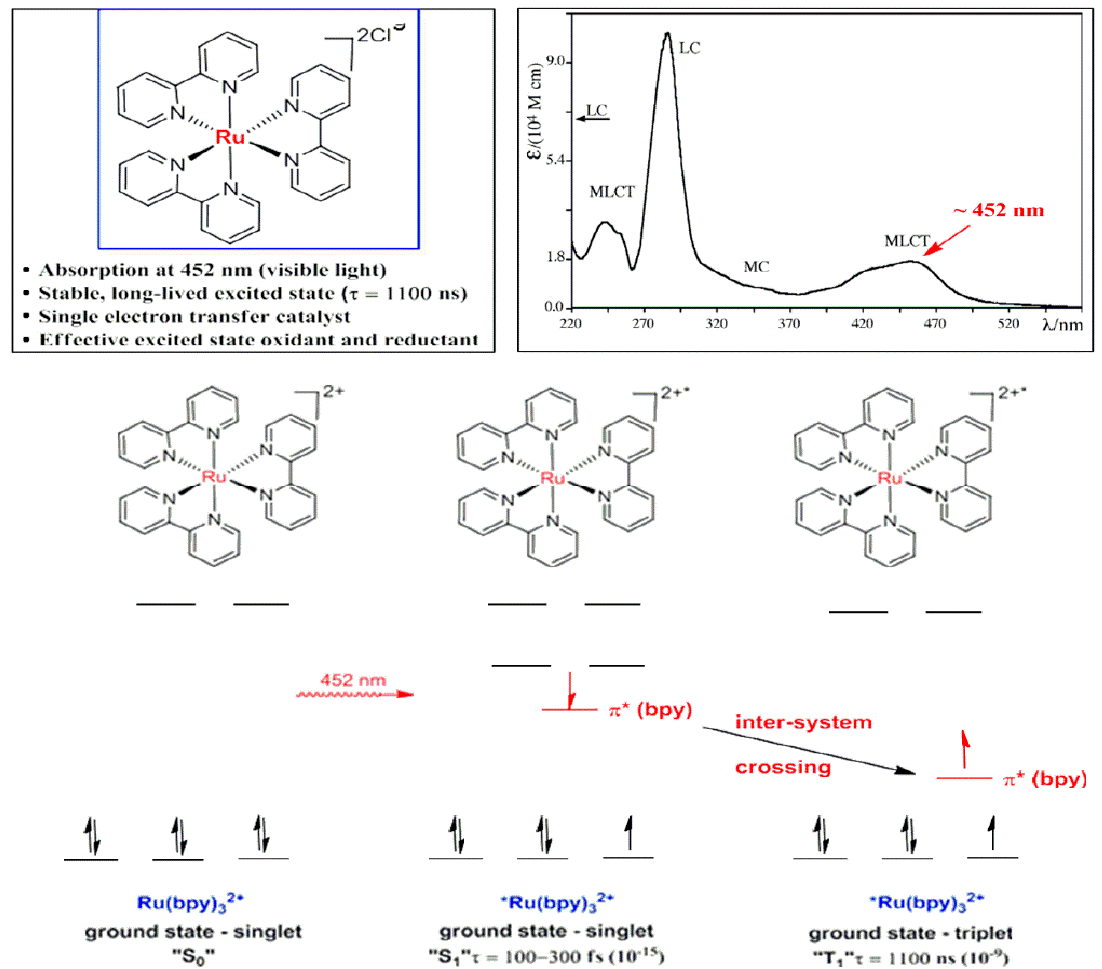
Scheme 2. Strong absorption of a Ru(bpy) 32+ complex in the visible wavelength